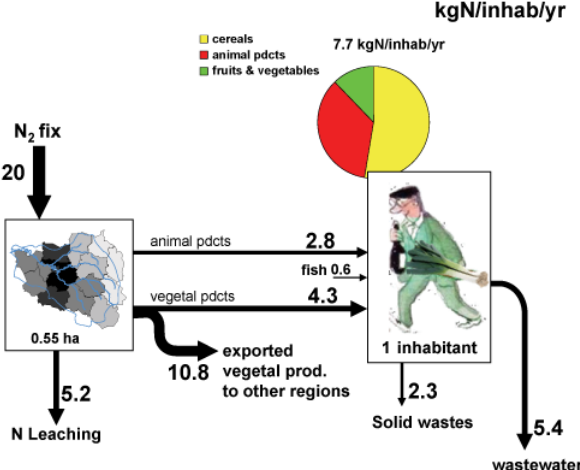
Fig. 6. Schematic representation of the nitrogen imprint of the food supply of one Paris inhabitant in the organic-local- demitarian scenario. The nitrogen fluxes involved are expressed in kgNinhab − 1 yr − 1